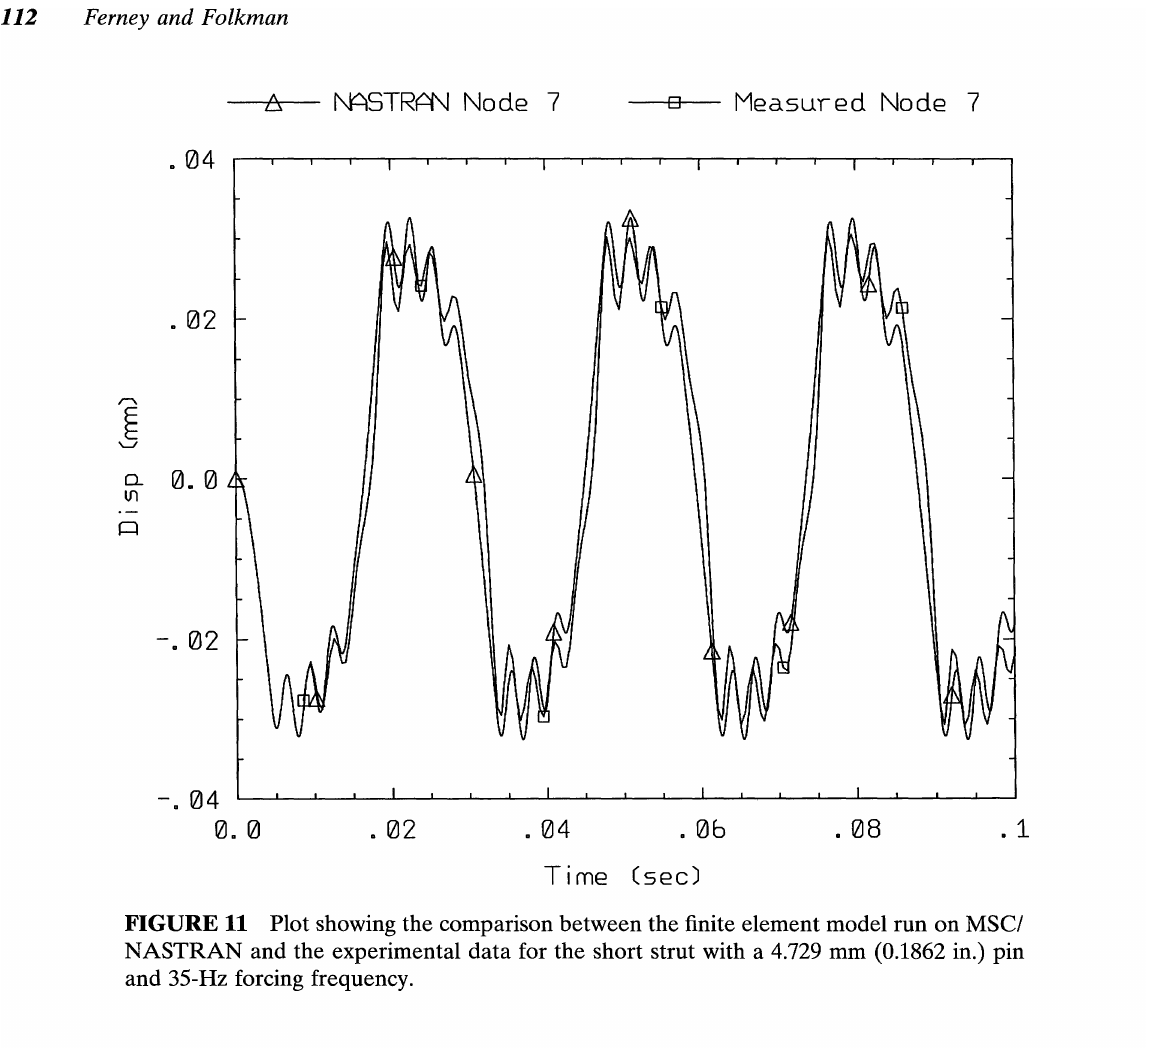
FIGURE 11 Plot showing the comparison between the finite element model run on MSC/ NASTRAN and the experimental data for the short strut with a 4.729 mm (0.1862 in.) pin and 35-Hz forcing